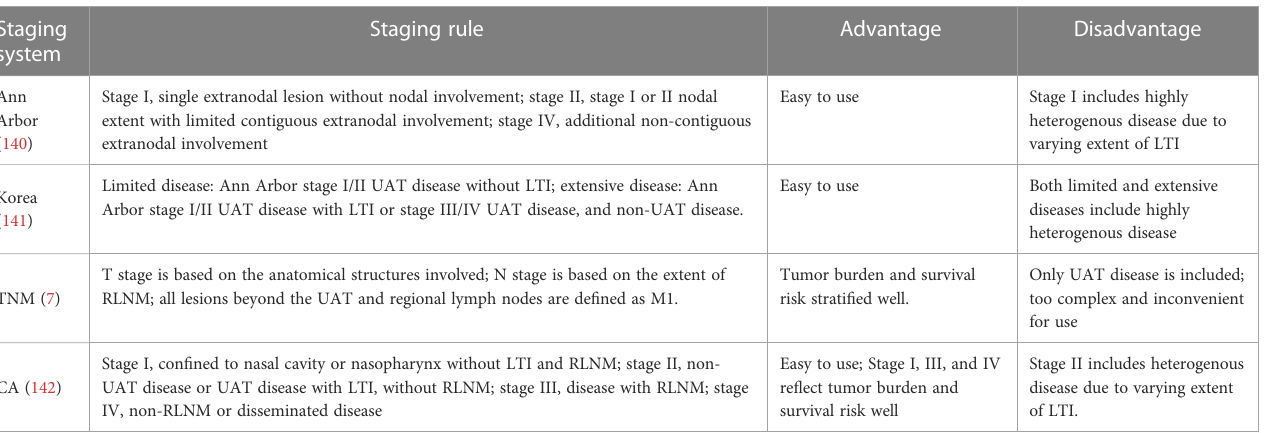
TABLE 1 Staging systems for